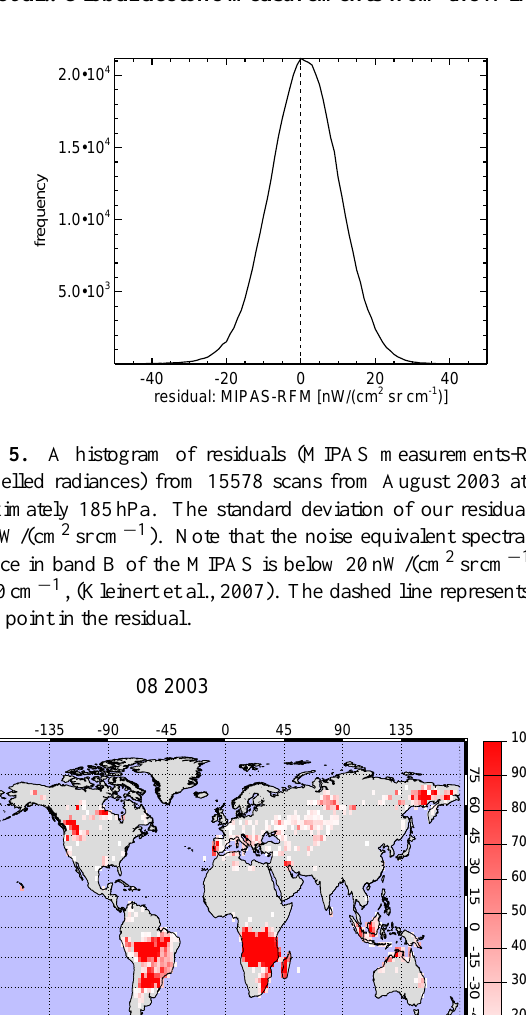
Fig. 6. MODIS fire counts for August 2003 gridded into 2.5 ◦ latitude x 2.5 ◦ longitude bins. Fire data points classed with both nominal and high certainty are included.